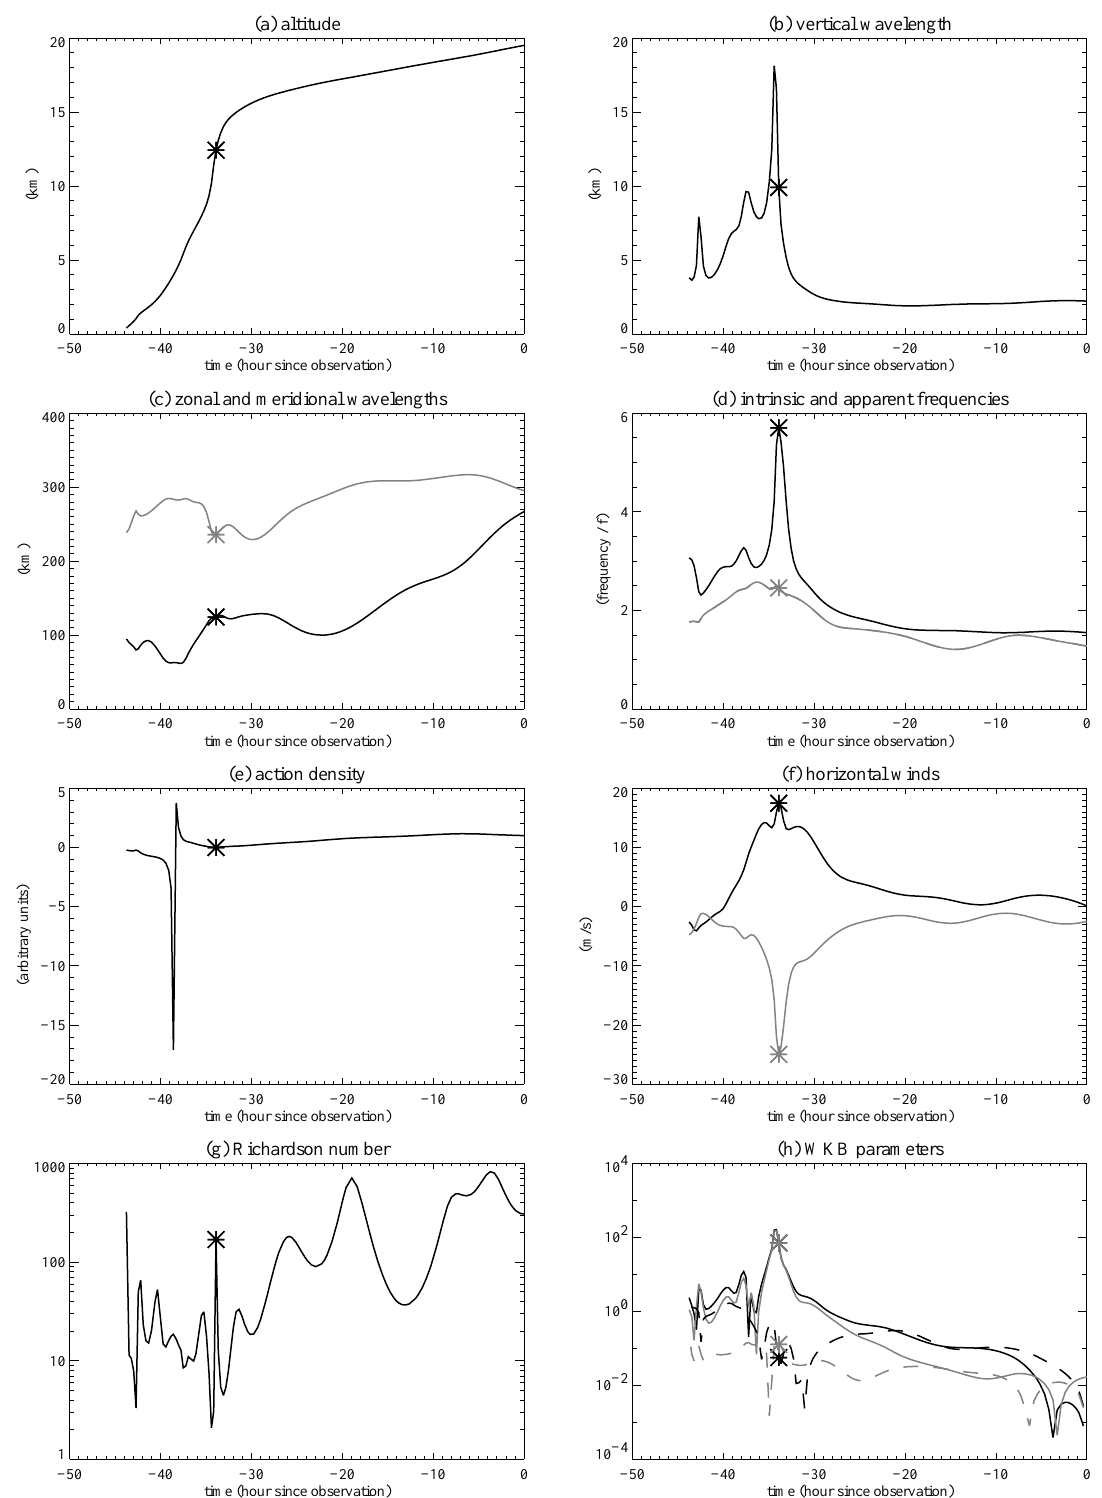
Fig. 4. Results of the backward ray-tracing simulation: (a) wave packet altitude, (b) vertical, (c) zonal (black) and meridional (grey) wavelengths, (d) intrinsic (black) and apparent frequency (grey), (e) action density; (f) zonal (black, positive eastward) and meridional (grey, positive northward) wind velocities, (g) Richardson number and (h) α (blacked dashed), β (grey dashed), γ (black) and δ (grey) (h) along the ray. The stars show the supposed time of generation (see